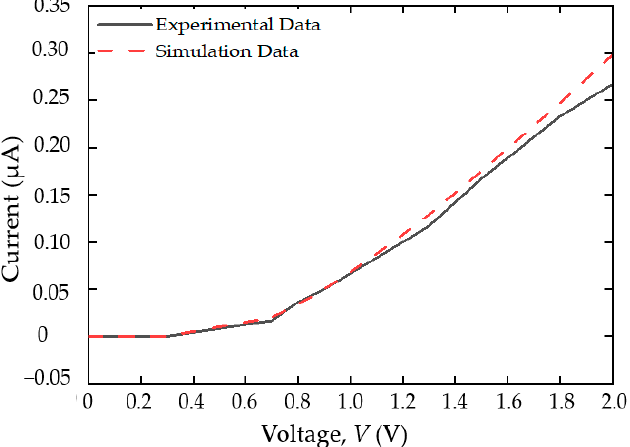
Figure 2. Comparison of IV characteristics between simulation and experimental data of Farhi et al. [16].